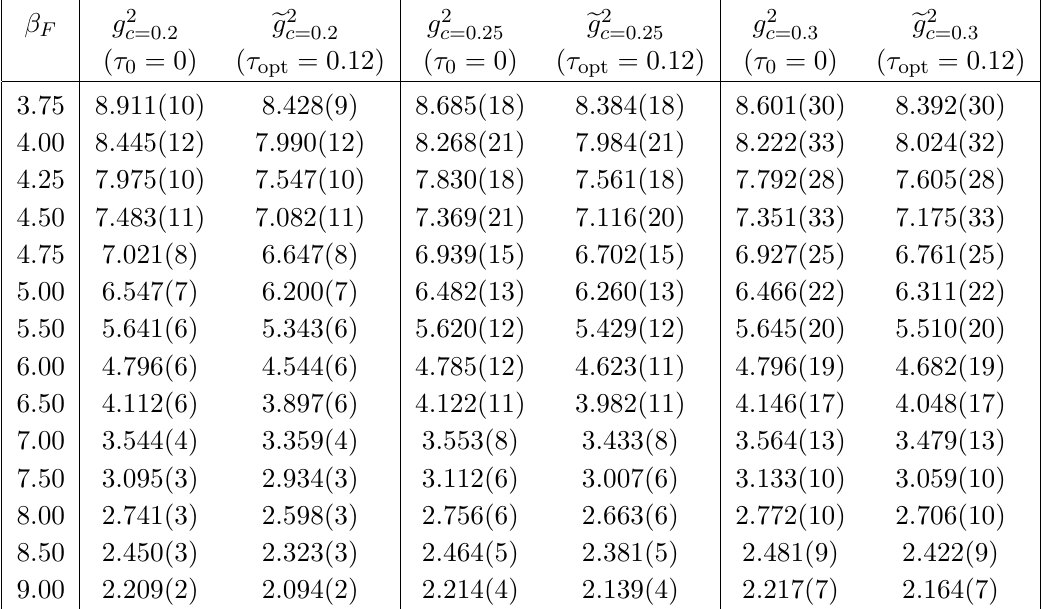
Table 20 . Renormalized gradient (cid:13)ow couplings based on the plaquette discretization of E ( t ) for the 30 4 lattice ensembles used in this work, with columns as in table